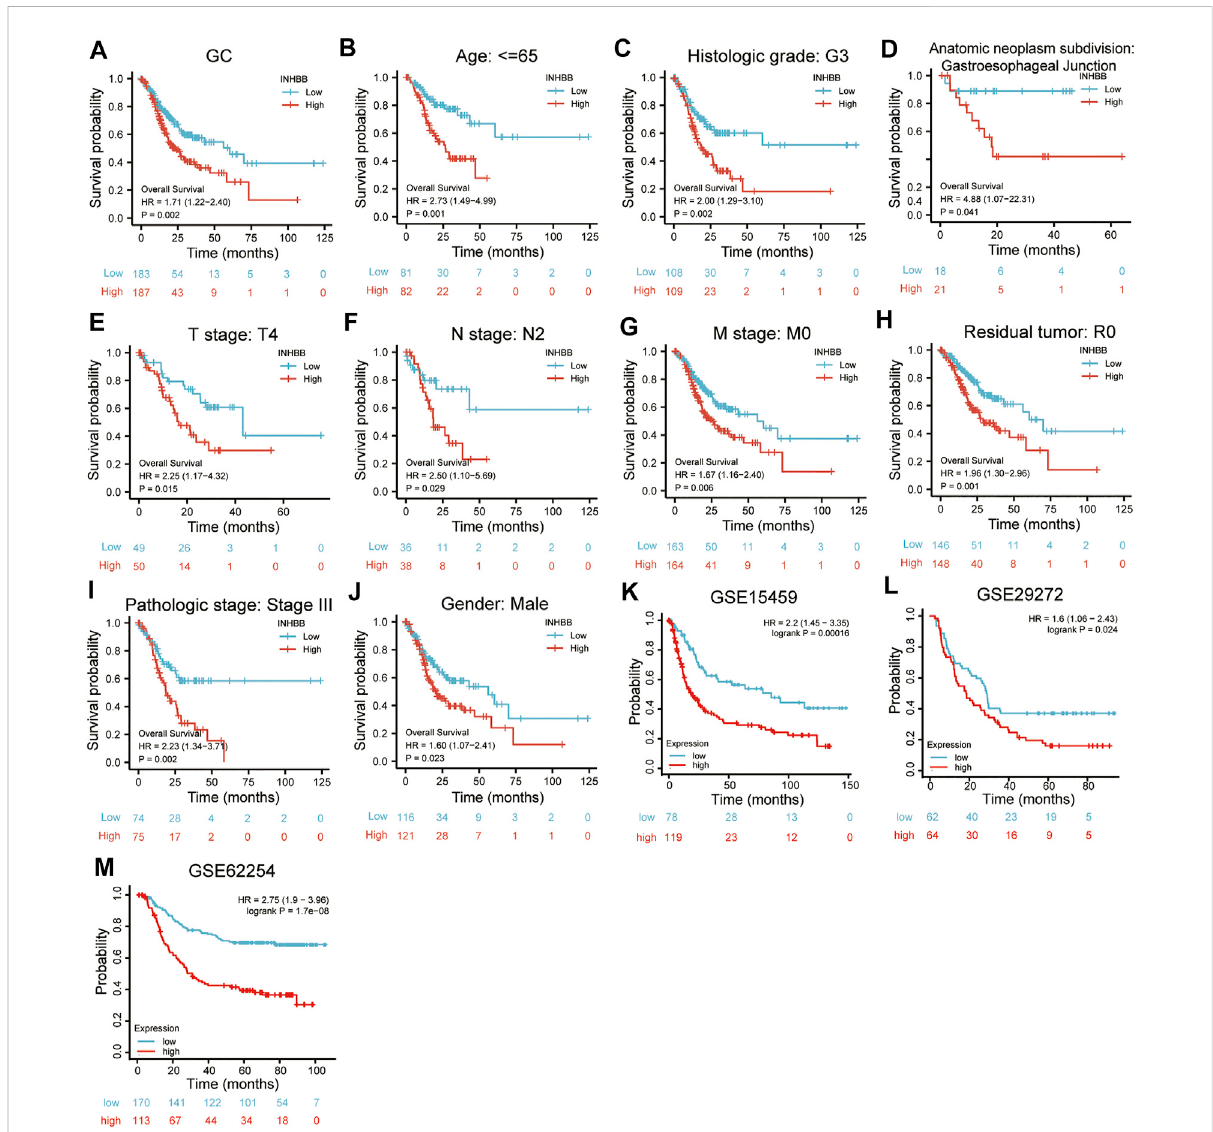
FIGURE 3 Kaplan-MeiersurvivalanalysisofINHBBexpressionand (A) prognosisinGCpatientdatafromTCGA, (B) age, (C) histologicalgrade, (D) anatomic neoplasm subdivision, (E) T stage, (F) N stage, (G) M stage, (H) residual tumor, (I) pathologic stage, (J) gender, prognosis in GC data from (K) GSE15459, (L) GSE29272, (M)